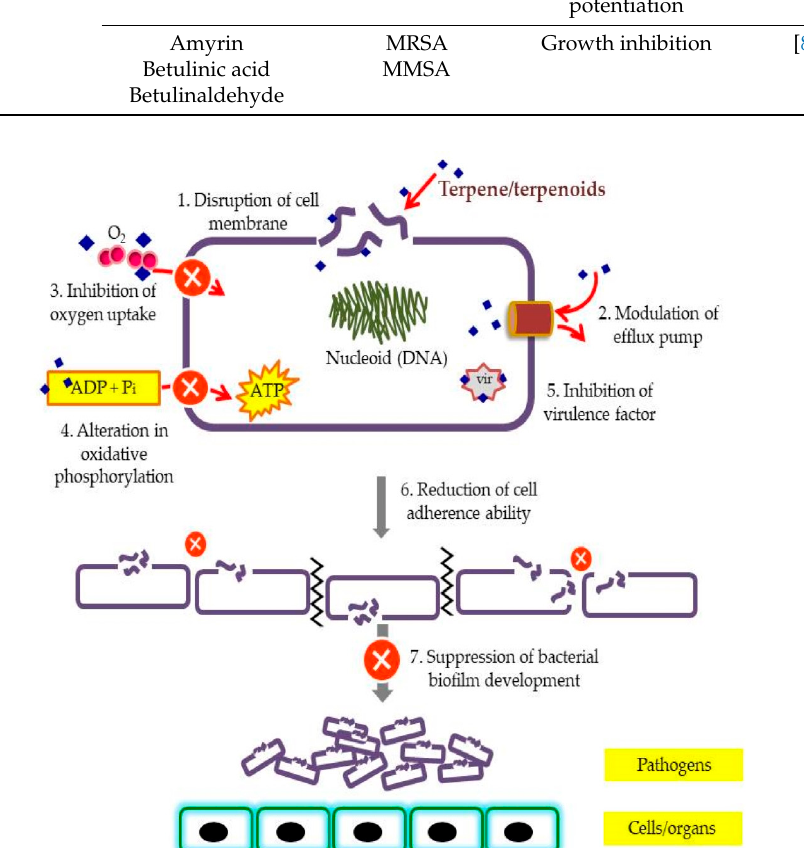
Figure 2. Postulated mode of action of terpene / terpenoids on antibiotic resistance pathogens and as combination therapies.